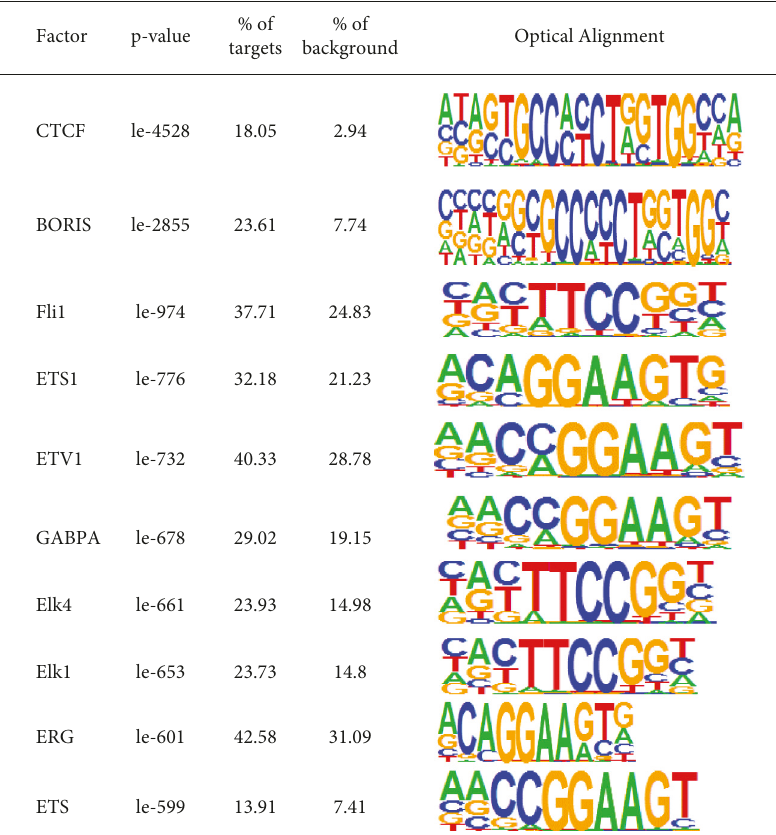
Table 1: Motif analysis of the chromatin open region in J76 cells.